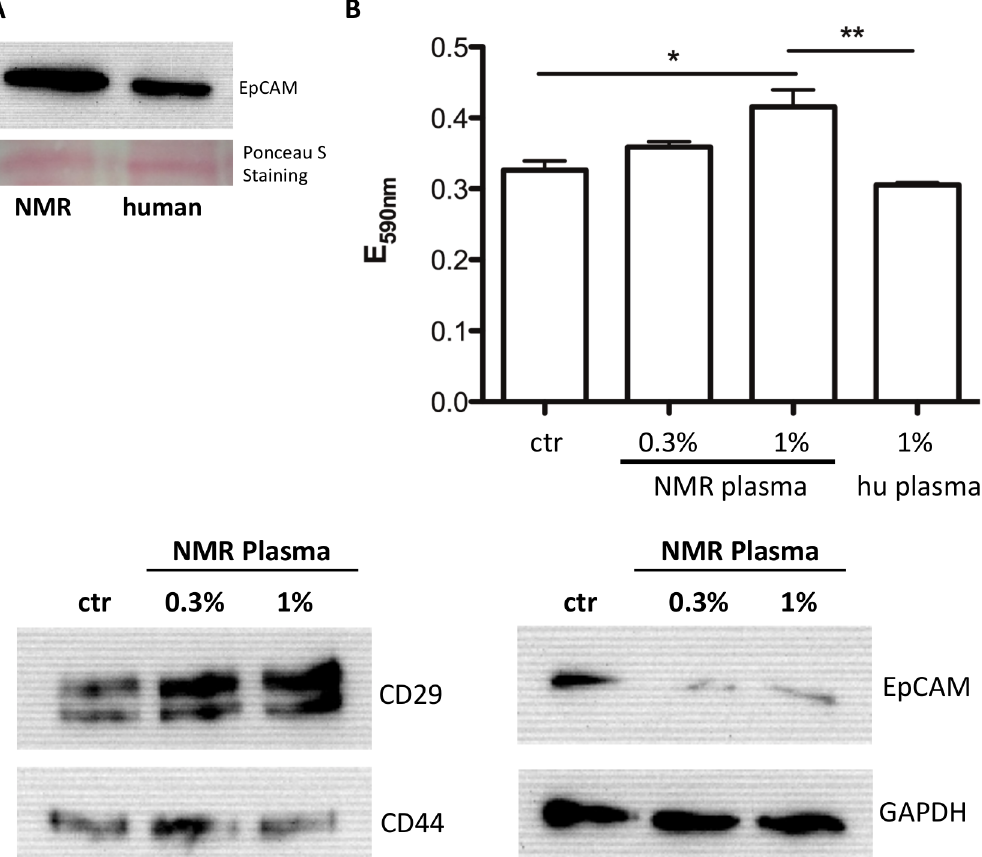
Fig 6. Adhesion induction by NMR plasma supplementation in human fibroblasts. The determination of the EpCAM protein in NMR and human liver samples were analysed by electrophoresis in 10% SDS-gel using 20 μ g protein in conjunction with immunoblotting using a monoclonal mouse anti-human EpCAM antibody (A). Human fibroblasts were cultured in medium supplemented with 0.3 or 1% NMR plasma for 24h and, controls were supplemented with PBS (ctr) or 1% human (hu) plasma), respectively. Cells were treated by trypsin/EDTA solution for exactly 1 min, washed and the remaining adherent cells were stained by Gentiana solution. The absorbance of the released dye is directly proportional to the number of adherent cells (B) ( ** — p < 0.01; * - 0.05). Western blot analysis for CD29, CD44, EpCAM and GAPDH was performed by electrophoresis in 8% SDS-gel using 10 – 25 μ g protein after 0.3 or 1% NMR plasma supplementation for 24h. CD29, CD44, EpCAM and GAPDH were detected with respective monoclonal antibodies